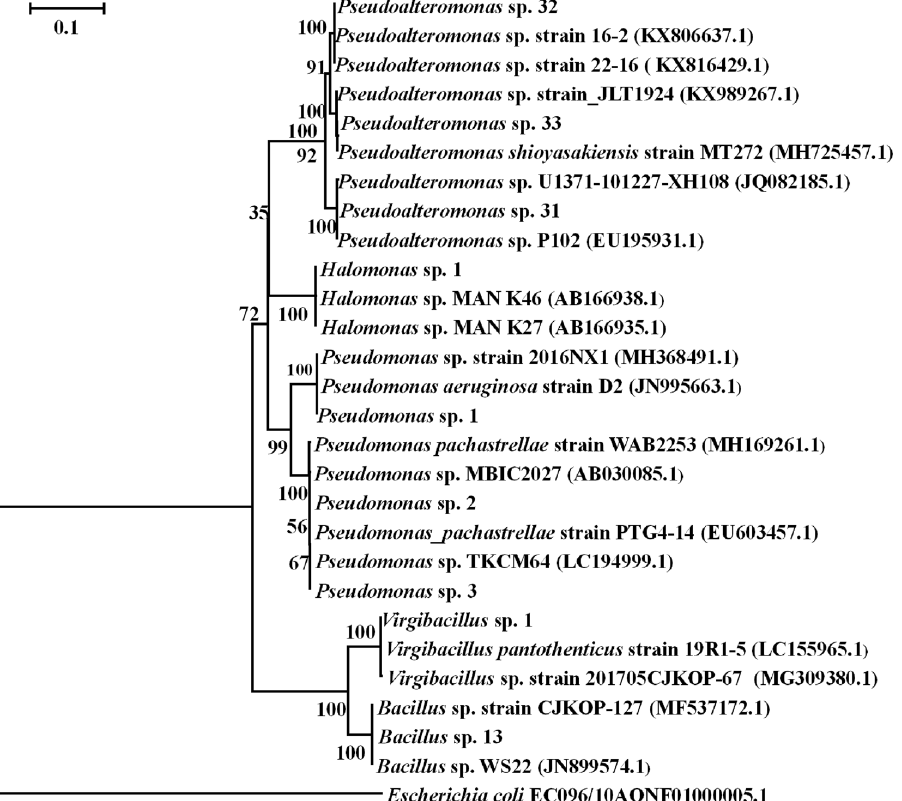
Figure 3. Phylogenetic tree of 16S rDNA gene sequences from tested deep-sea bacteria through Neighbor- Joining method and Jukes–Cantor model. Scale bar = 0.1 substitutions per nucleotide